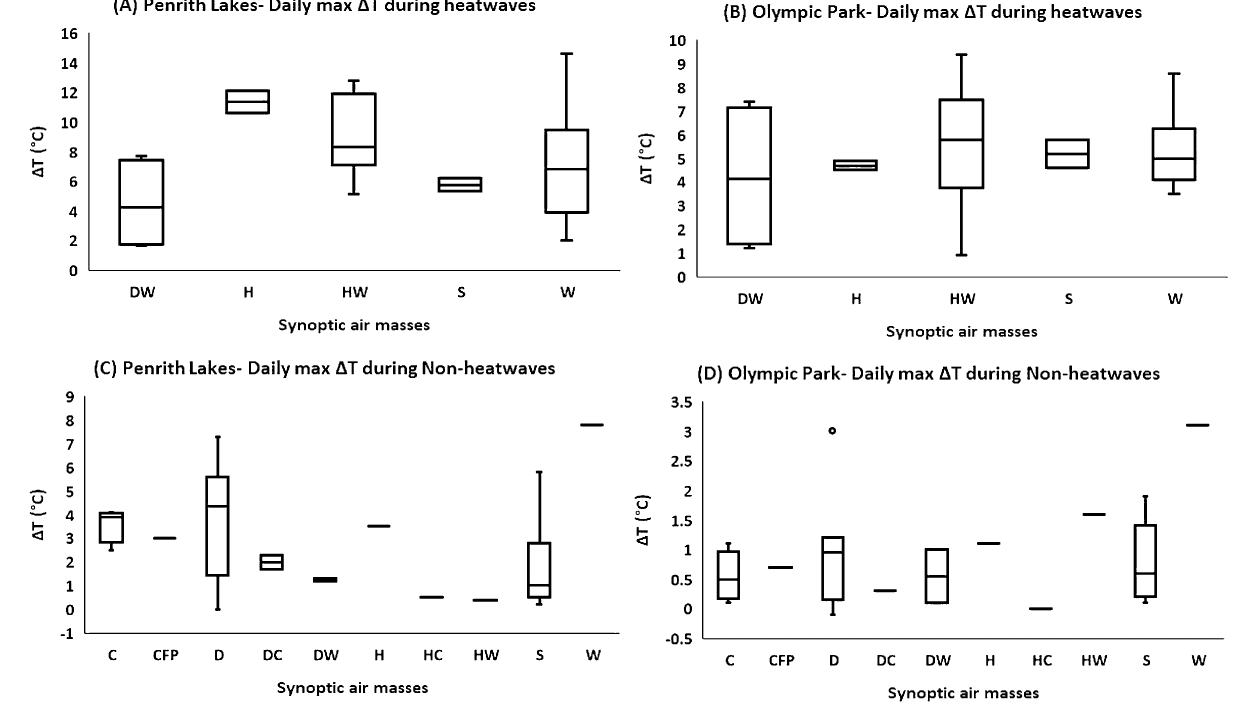
Figure 7. Synoptic air-masses and daily max ΔT during heatwaves and non-heatwaves). ( A) Penrith Lakes during heatwaves, ( B) Olympic Park during heatwaves, ( C) Penrith Lakes during non-heatwaves, ( D) Olympic Park during non-heatwaves. The boxplots are plotted according to the general convention (upper and lower extremes: Q1-1.5*IQR and Q3 +